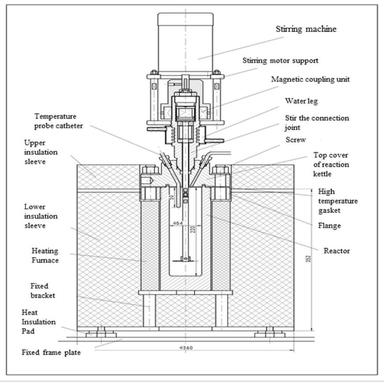
High–temperature and high–pressure reaction kettle.